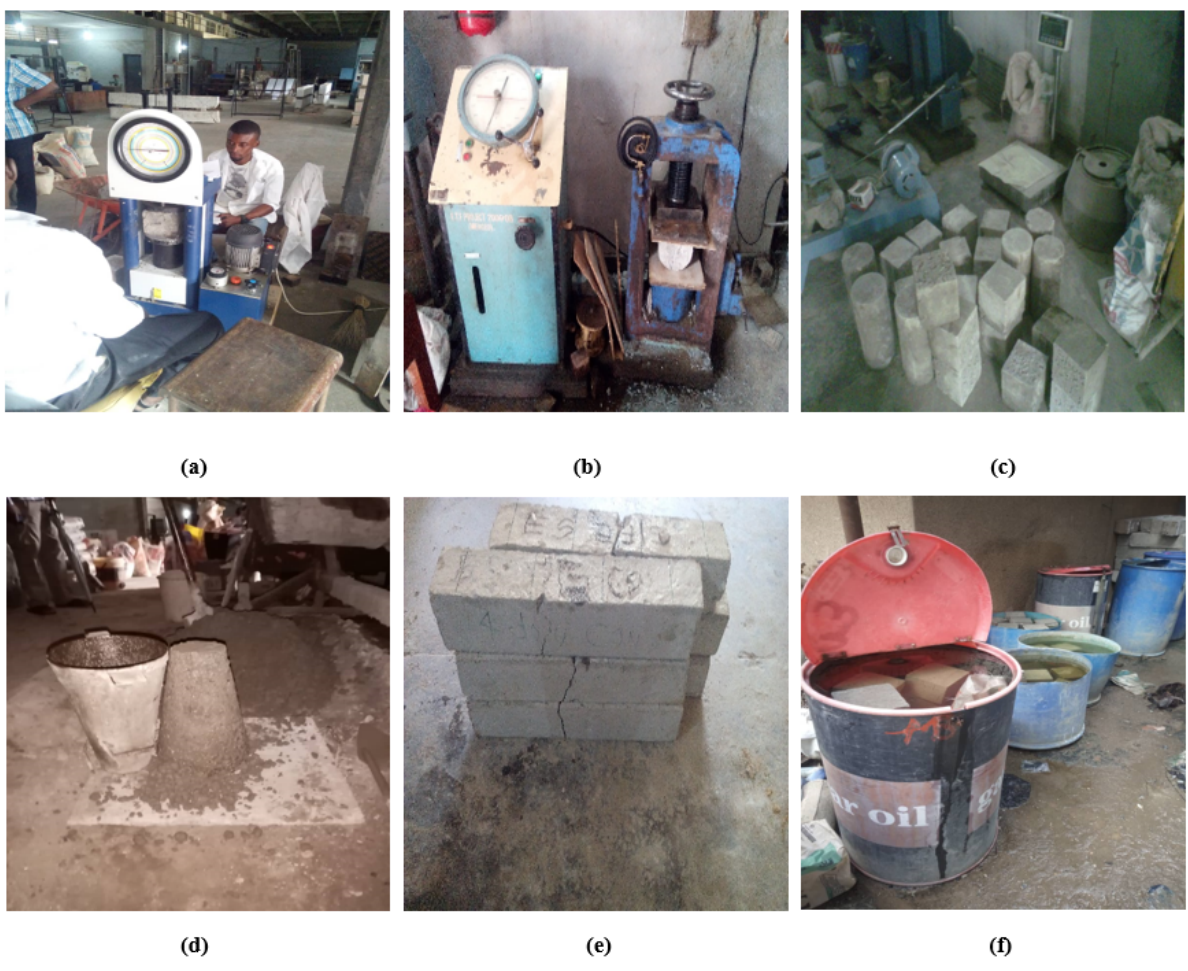
Figure 1. Laboratory Equipment and Experimental Activities (a) & (b) Avery Dension Universal Testing Machine for Compressive and Split Tensile Strength (c) Sample Measurement using Weighing Machine (d) Slump Test (e) Tested Concrete Beams (f) Concrete Cubes Immersed in Curing Media A total number of 72Nos. 150mm concrete cubes, 72Nos. 150mm × 300mm concrete cylinders and